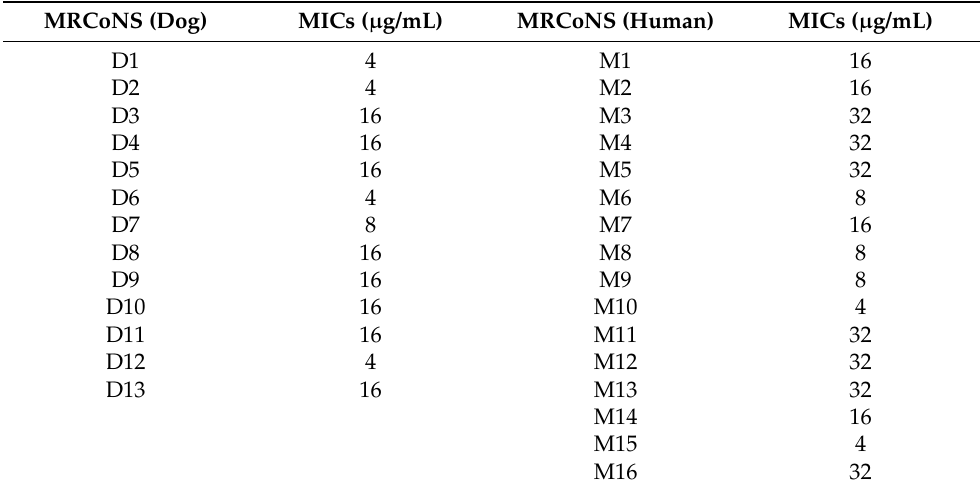
Table 4. MIC of oxacillin to MRCoNS isolated from dogs and their owners.